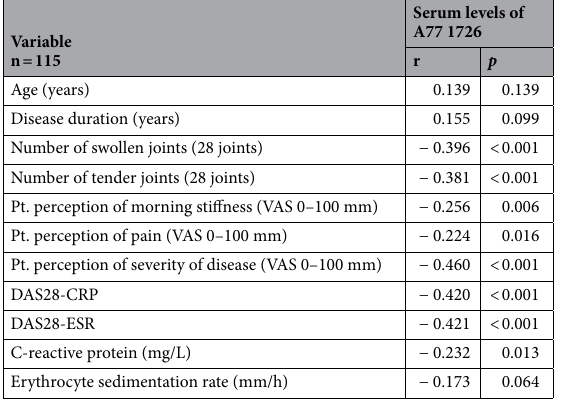
Table 2. Correlations between serum A77 1726 levels and clinical and laboratory variables. Correlations were obtained using Pearson correlation tests (r value). Abbreviations: Pt patient, VAS visual analogue scale, DAS28-CRP disease activity score using C-reactive protein, DAS28-ESR disease activity score using erythrocyte sedimentation rate.